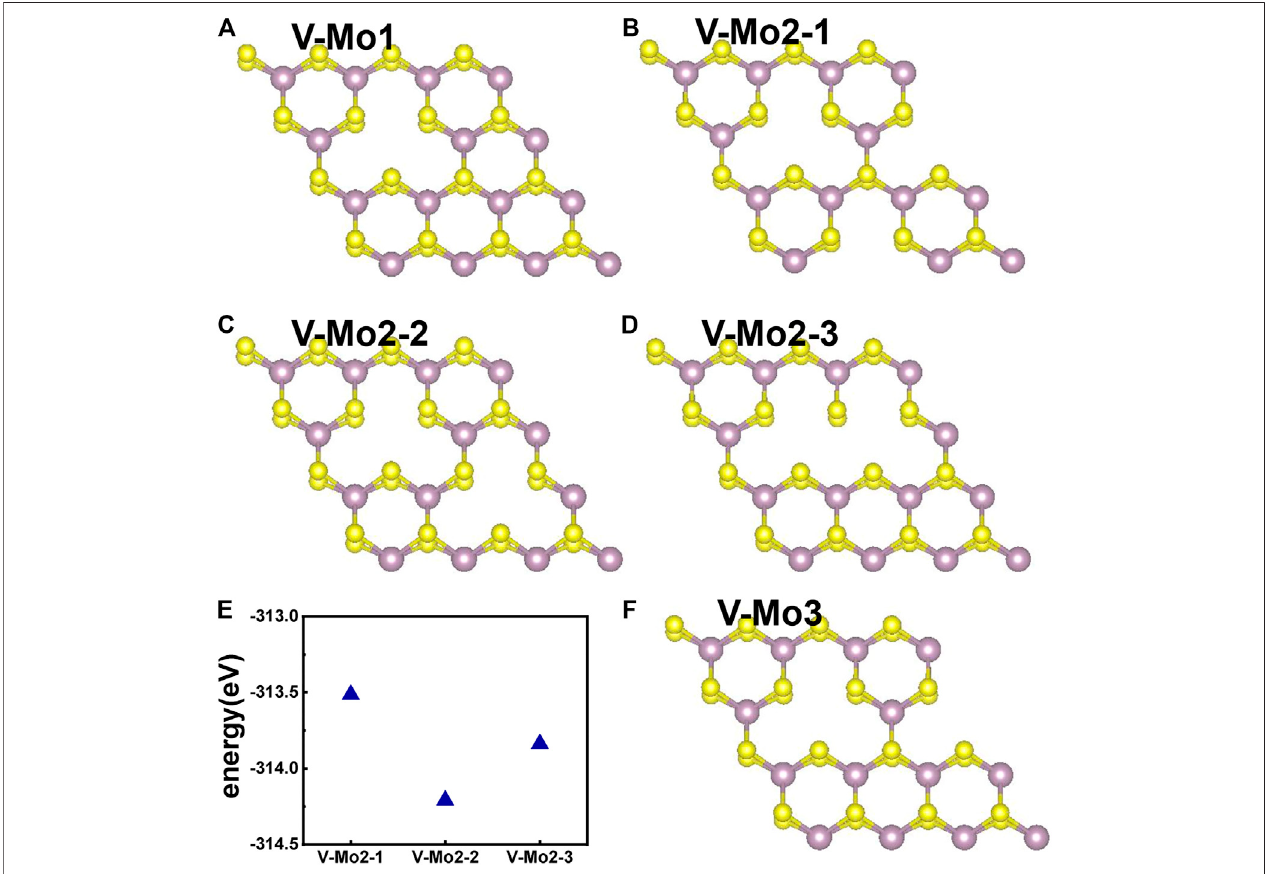
FIGURE 7 | Different Mo-vacancy defect structures of 2H-MoS 2 , rotated by an angle to distinguish the two S layers: (A) single Mo-vacancy; (B – D) three con fi gurations of double Mo-vacancies; (F) one con fi guration of triple Mo-vacancies; (E) comparison of the ground-state energies of different con fi gurations of double